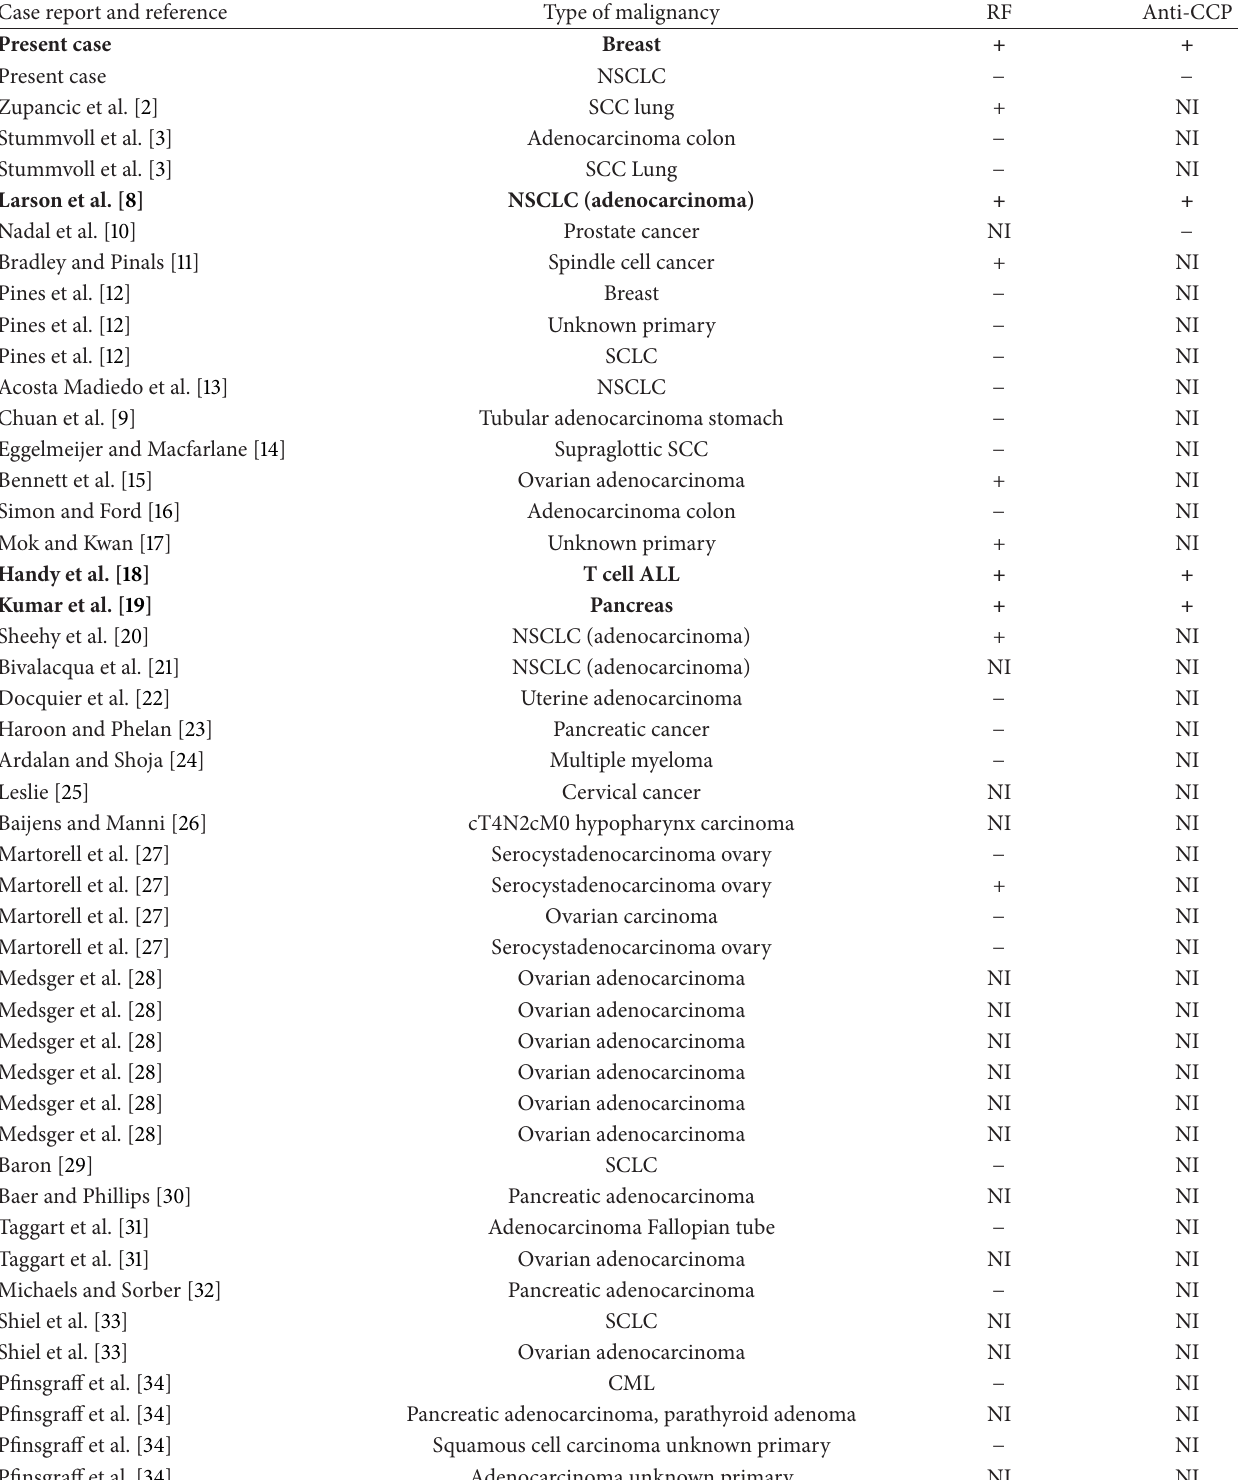
Table 1: Malignancies associated with carcinomatous polyarthritis. Four cases, highlighted in bold, have shown anti-CCP positivity. Rheumatoid factor (RF), anti-citrullinated protein antibody (anti-CCP), positive (+), negative ( − ), not included (NI), Non-Small Cell Lung Cancer (NSCLC), Squamous Cell Cancer (SCC), Small Cell Lung Cancer (SCLC), Acute Lymphoblastic Leukemia (ALL), Chronic Myeloid Leukemia (CML), and Chronic Lymphoid Leukemia